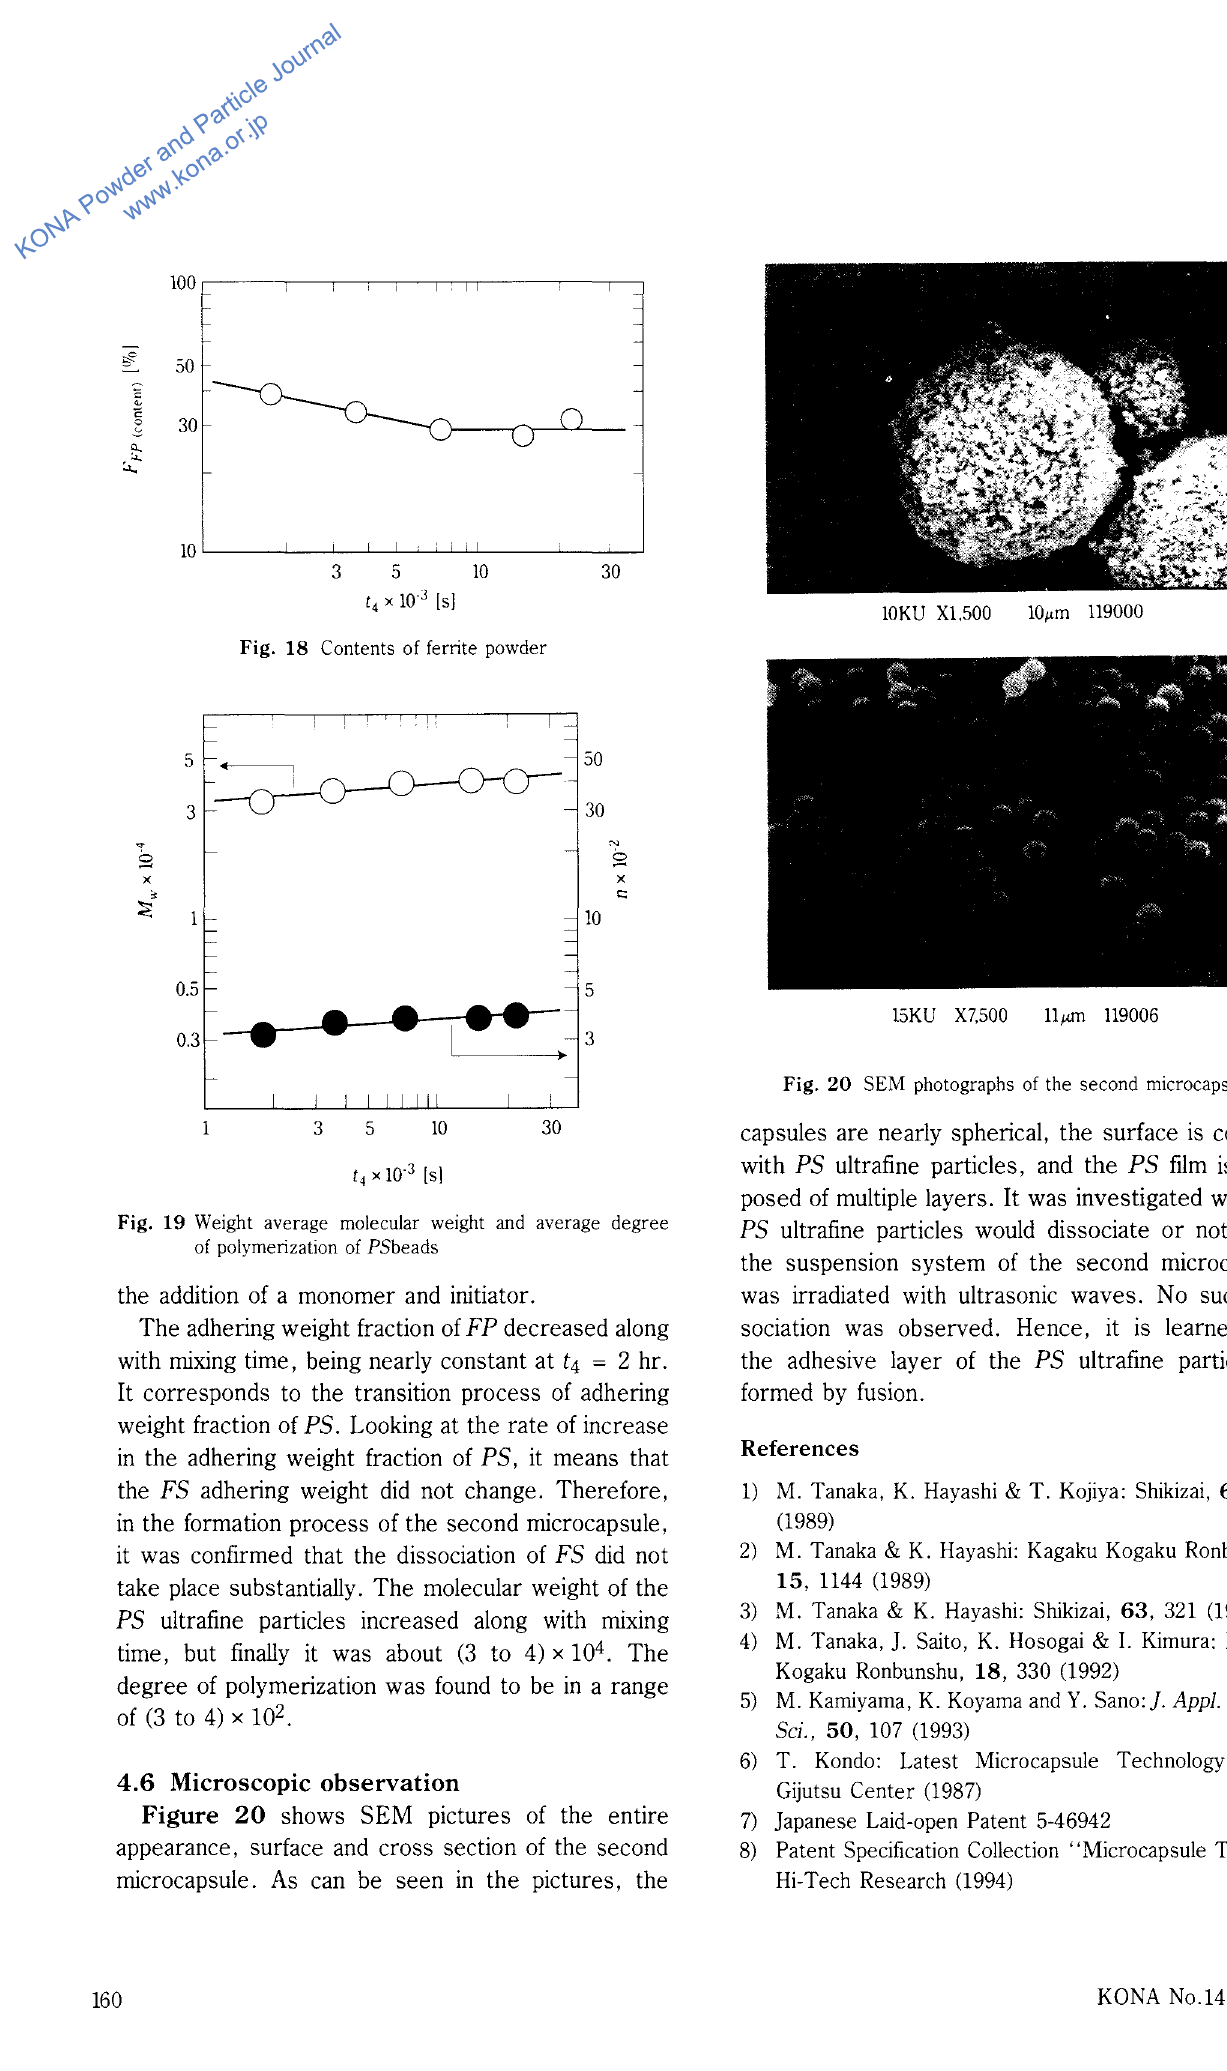
Fig. 18 Contents of ferrite powder